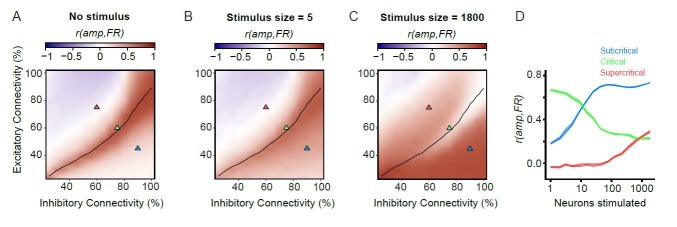
Firing rates and amplitude of alpha oscillations are not always coupled.(A) For unstimulated networks, alpha-oscillation amplitude and firing rate are only strongly coupled in the critical regime. Pearson correlation of mean amplitude and firing rate calculated on 100 ms windows for unstimulated networks. (B,C) Coupling between post-stimulus oscillatory amplitude and firing rate is dependent on stimulus size. Pearson’s correlation coefficient between the firing rate (1–50 ms), and oscillation amplitude for the same time interval. For the weak stimulus (B, n = 5), the critical networks show stronger coupling between firing rate and amplitude compared to their sub/supercritical counterparts. However, for the strong stimulus (n = 1800) critical networks show weaker coupling between firing rate and amplitude, compared to their sub-/super-critical counterparts. (D) Coupling of post-stimulus amplitude and firing rate for the 3 example networks highlighted with triangles on the phase space (A-C), for the entire range of stimulus sizes.